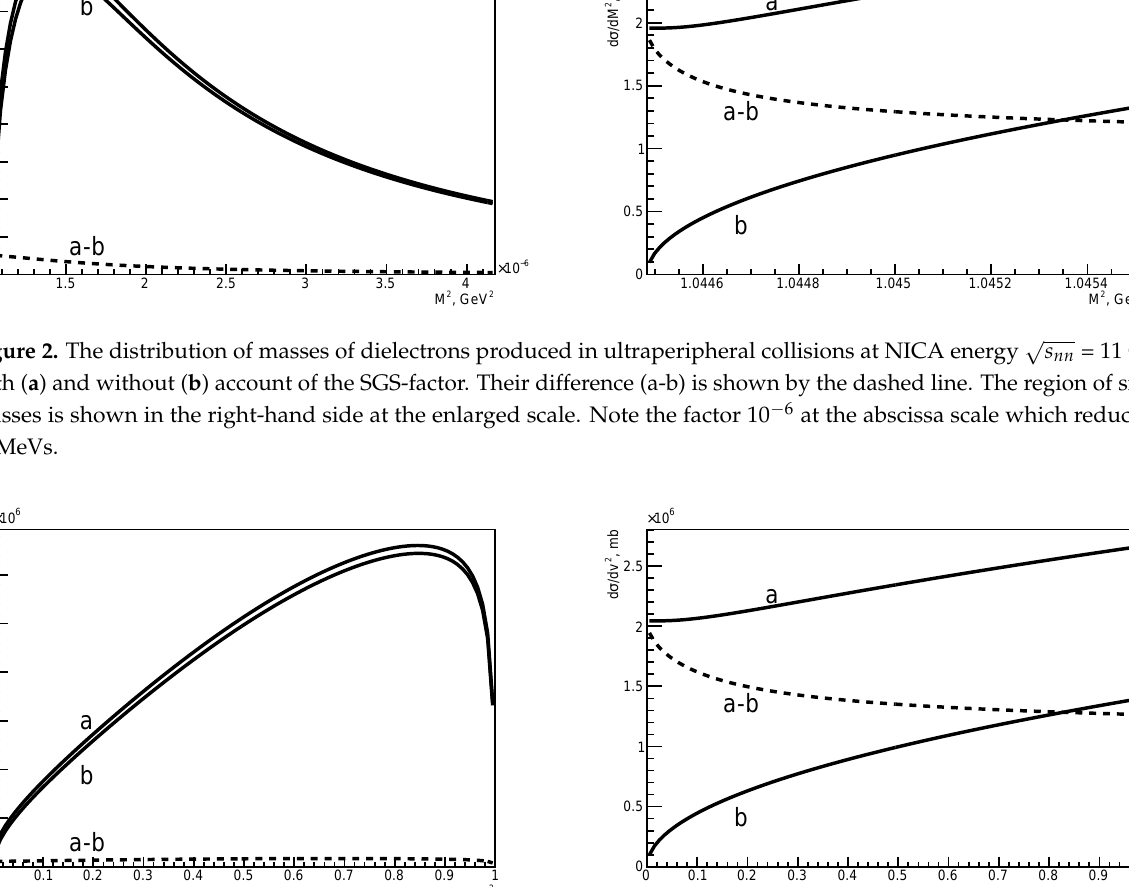
Figure 3. The distribution of the relative velocities in dielectrons produced in ultraperipheral collisions at NICA energy √ s nn = 11 GeV with ( a ) and without ( b ) account of the SGS-factor. Their difference (a-b) is shown by the dashed line. The velocities for the region of small masses are shown in the right-hand side. Note the factor 10 − 3 at the abscissa